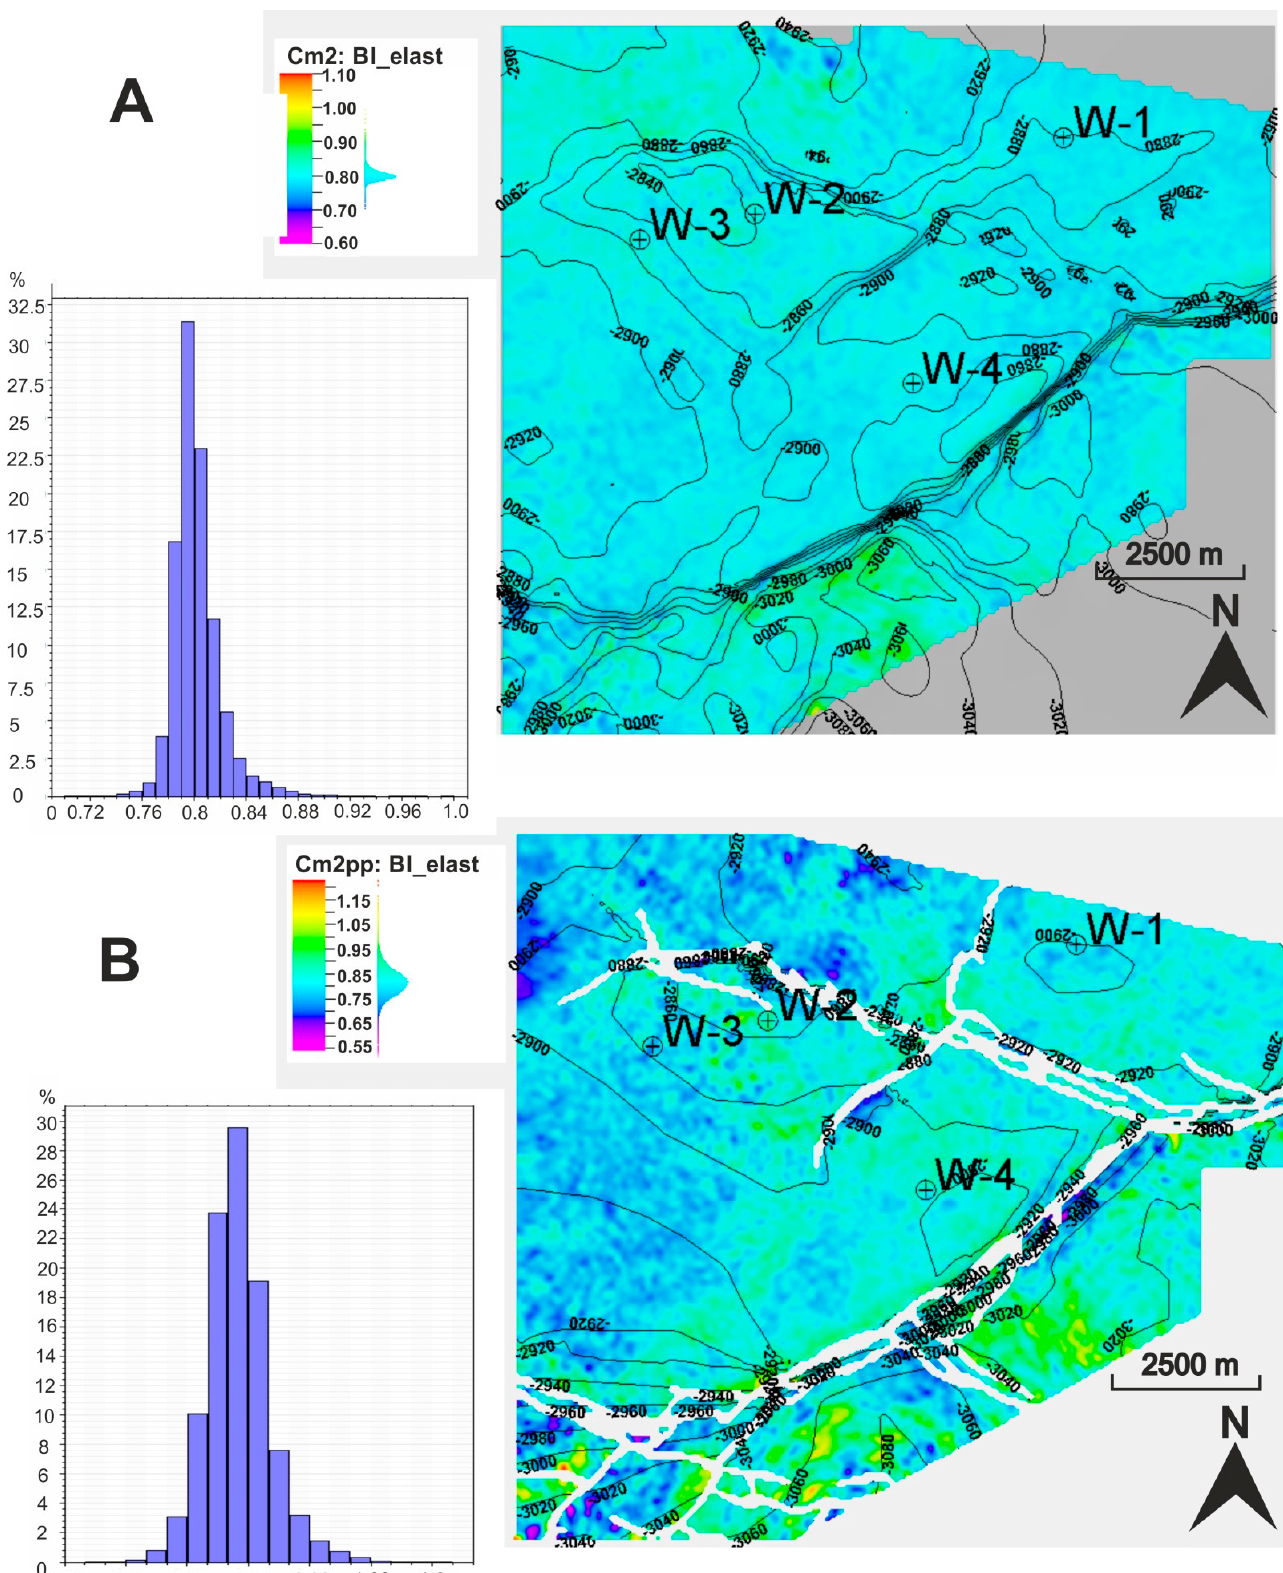
Figure 8. Average BI_elast calculated with the use of results of seismic inversion in the interval ( A ) of the Middle Cambrian (Cm2) and ( B ) the evaluated reservoir interval of sandstones of the Paradoxides Paradoximus.